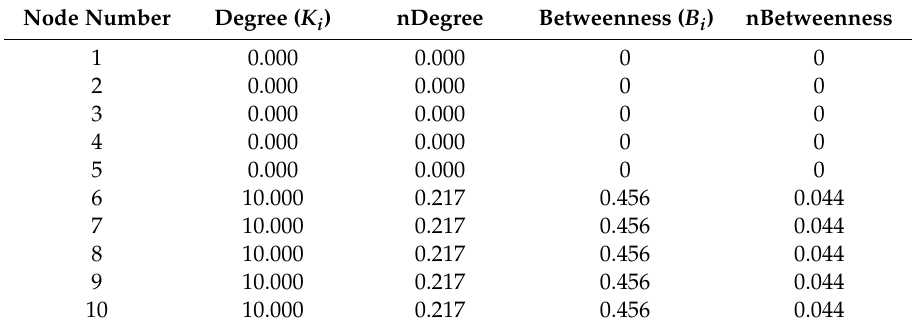
Table 3. Node degree and betweenness centrality of the air transportation unweighted network.